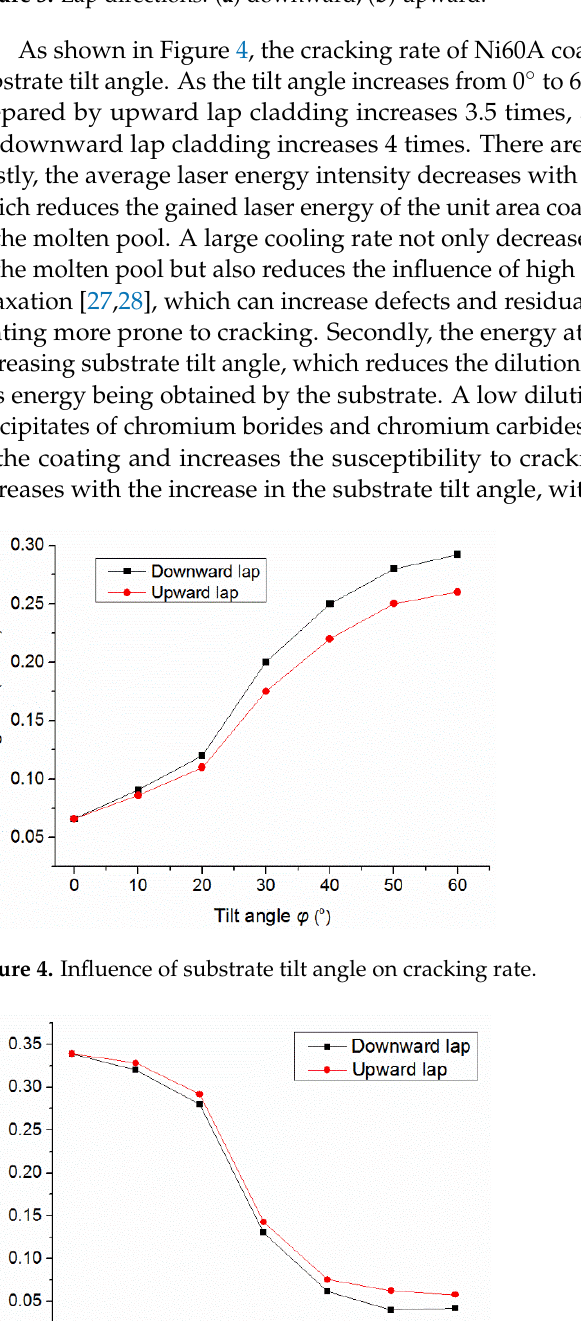
Figure 4. Influence of substrate tilt angle on cracking rate.